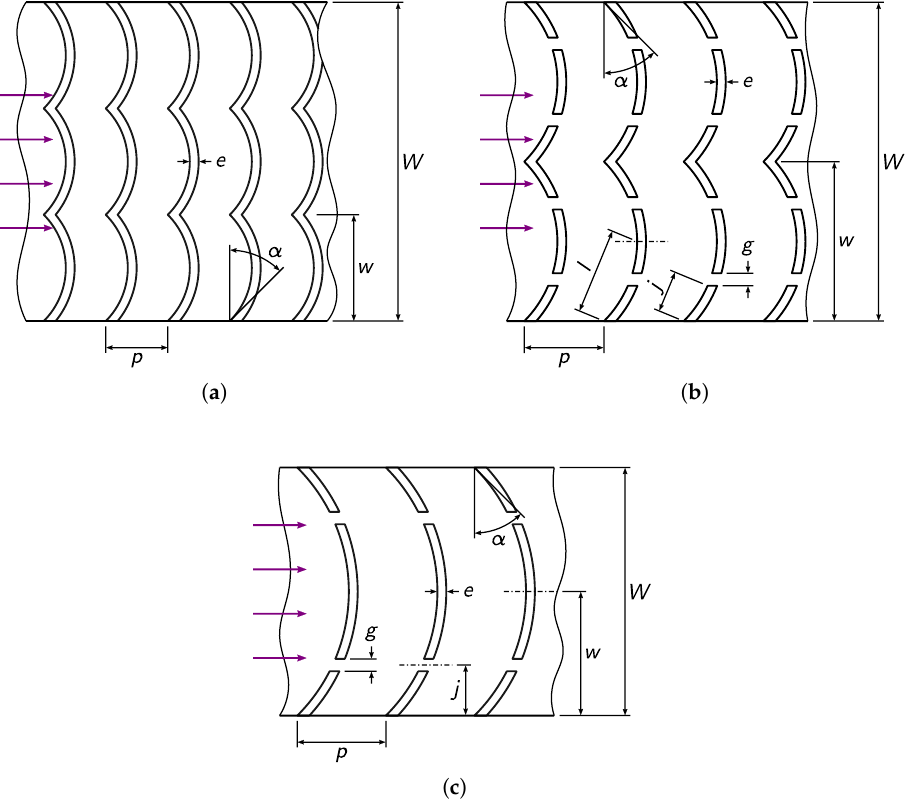
Figure 9. Rib arrangement and roughness parameters of absorber plates with curved